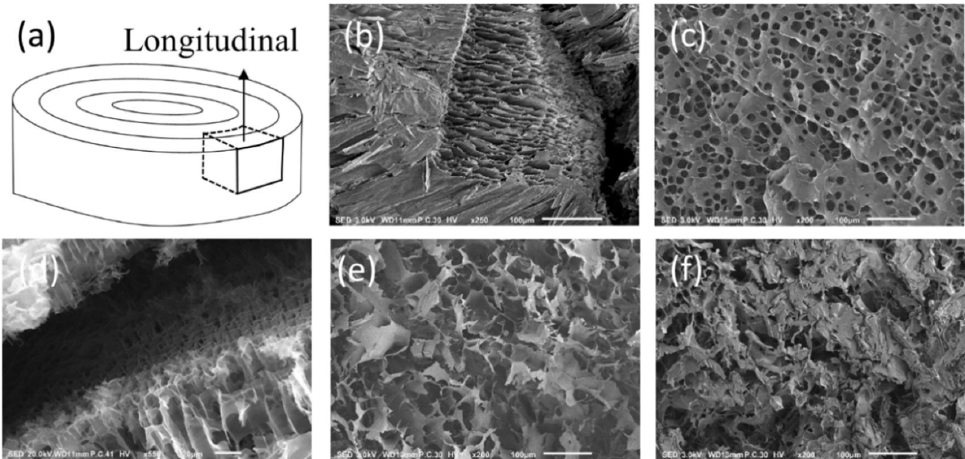
Figure 5. Cross-sectional SEM images in the longitudinal direction parallel to the cold stage: ( a ) schematic of the direction of the observation and ( b )–( f ) SEM images of aerogels prepared from different XG:CNC ratios of 0:1, 1:100, 1:50, 1:10, and 1:4, respectively.